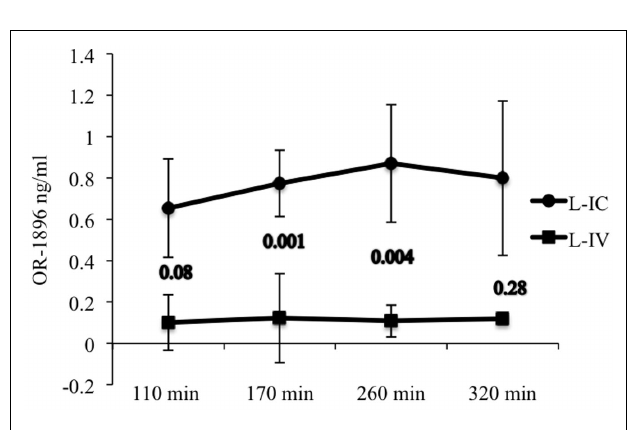
FIGURE 5 | Concentration of metabolite OR-1896, the active metabolite of levosimendan in the plasma samples 110, 170, 260, and 320min after the onset of levosimendan administration. L-IV, levosimendan infusion-group; L-IC, intracoronary